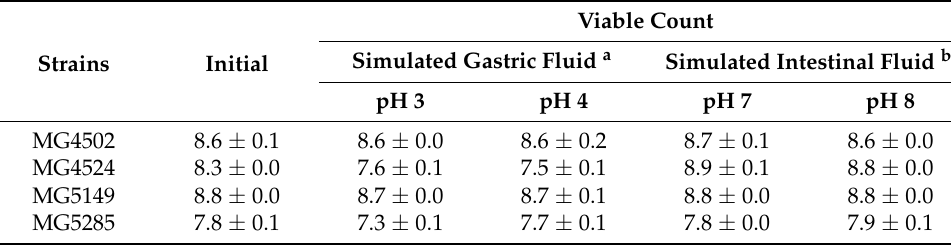
Table 2. Survivability of selected strains under simulated gastrointestinal